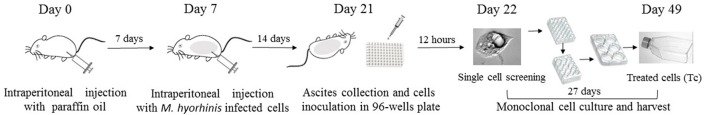
Flowchart of Mycoplasma elimination. Aseptic inflammation was induced in BALB/c mice by intraperitoneal injection (i.p) with 0.5 ml sterile paraffin oil 7 days before cells injection. 1d M(+) cell were intraperitoneal injected with a 0.5 ml of cell suspension (4 × 106/ml) in mice in day 7. Cells from the ascites were collected and inoculated in 96-well plate in day 21. After 12 h, the single attached cells were screened by microscopy and cultured for 27 days. Cells were harvested in 25-cm2 culture flasks in day 49 for further experiments.